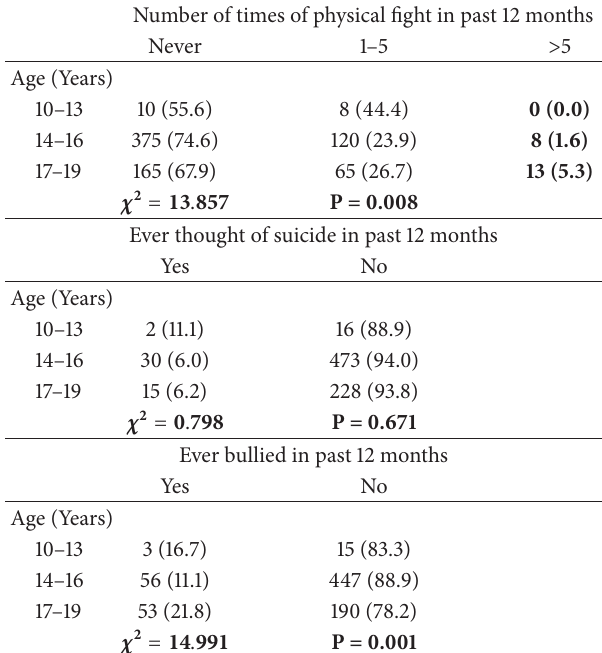
Table 8: Associations of social class with specific manifestation of behavioral